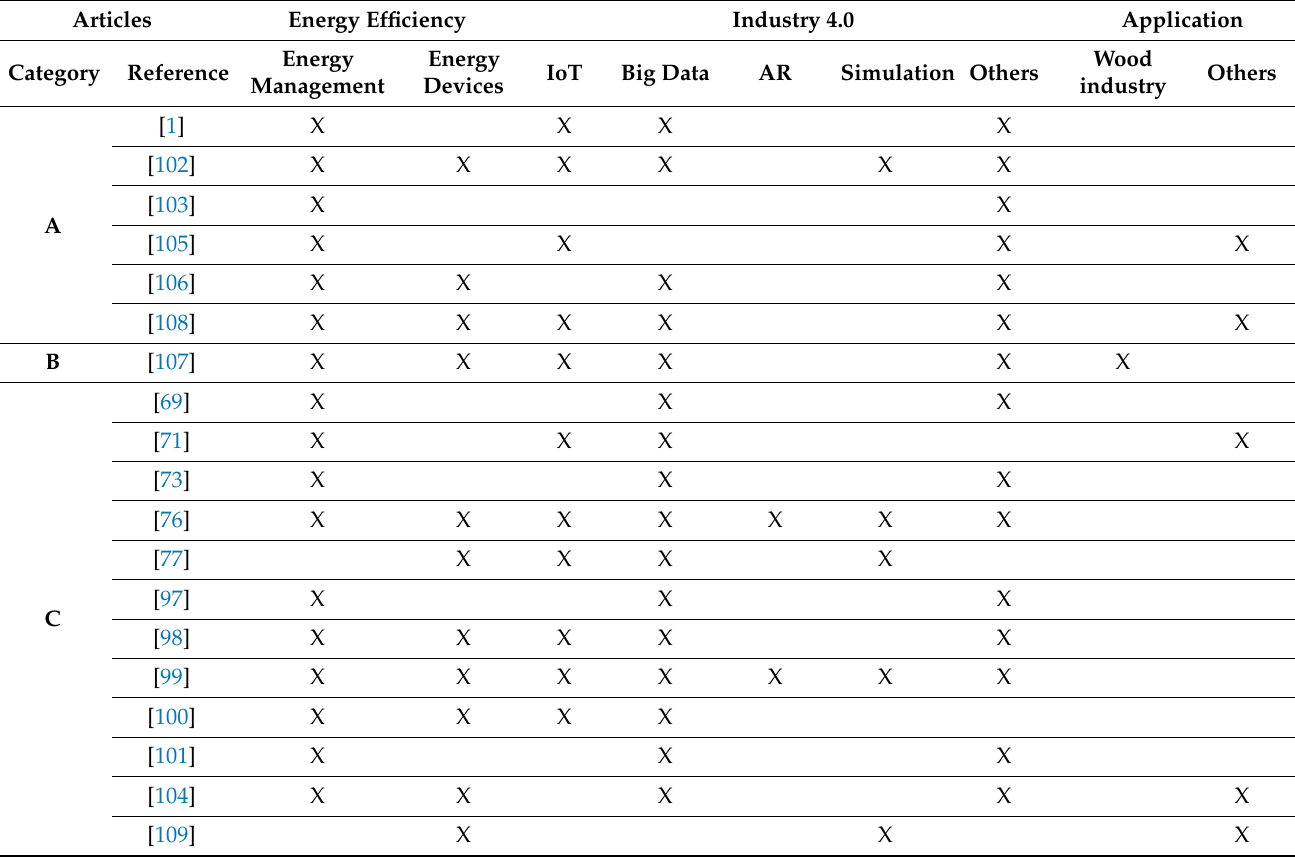
Table 2. Mapping of previously published papers in the energy efficiency and Industry 4.0 in manufacturing (especially wood